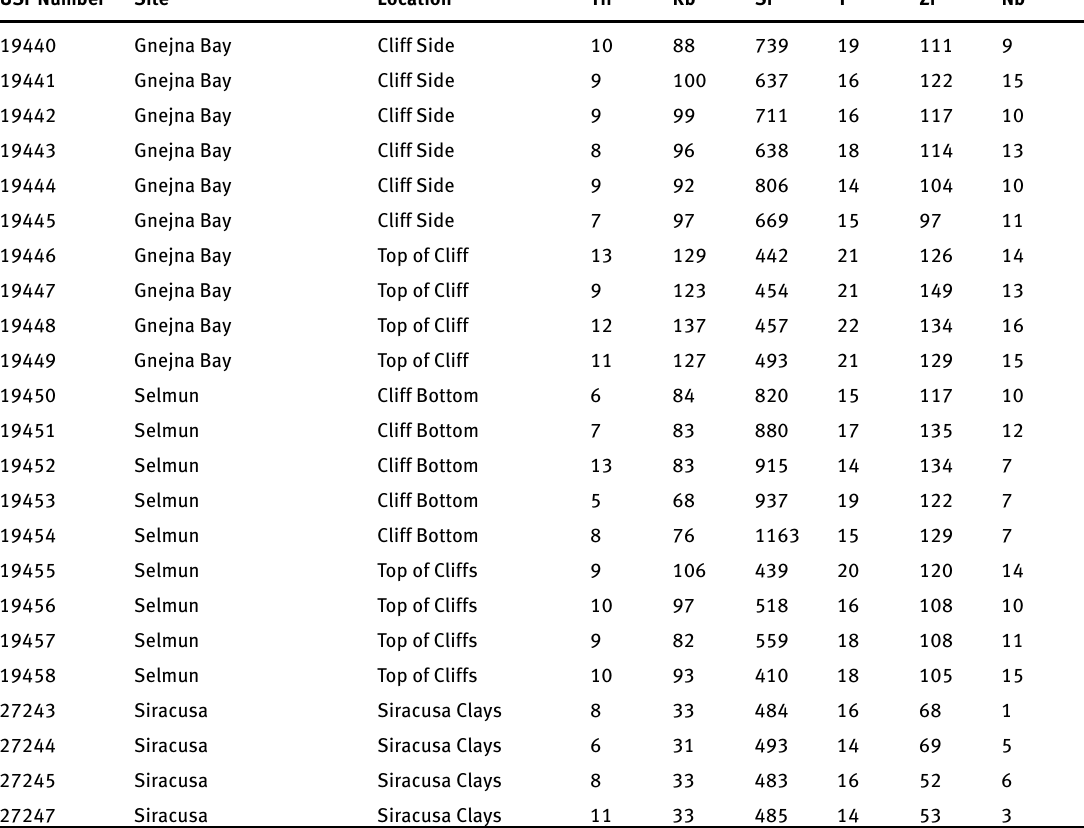
Table 3. Trace elemental data for geological clay materials